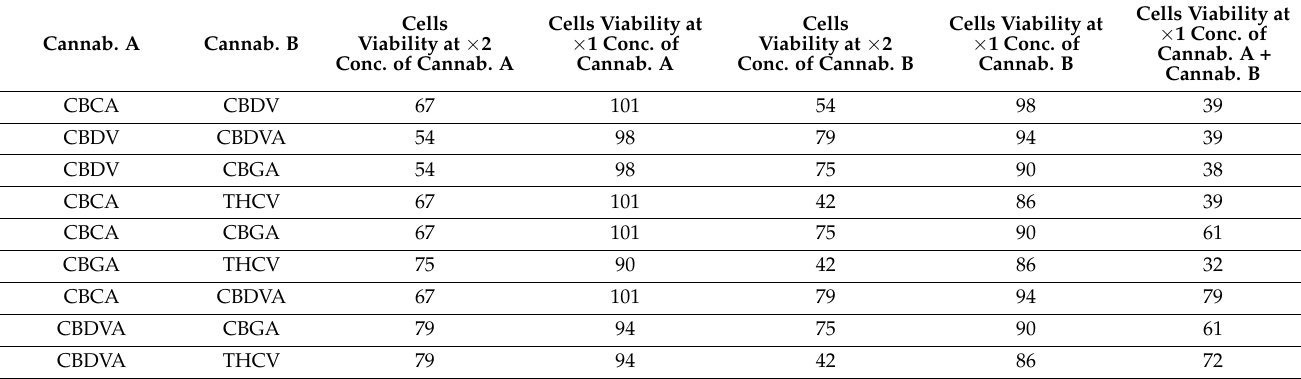
Table 3. The effect of combinations of cannabinoids on polyp cells’ viability.